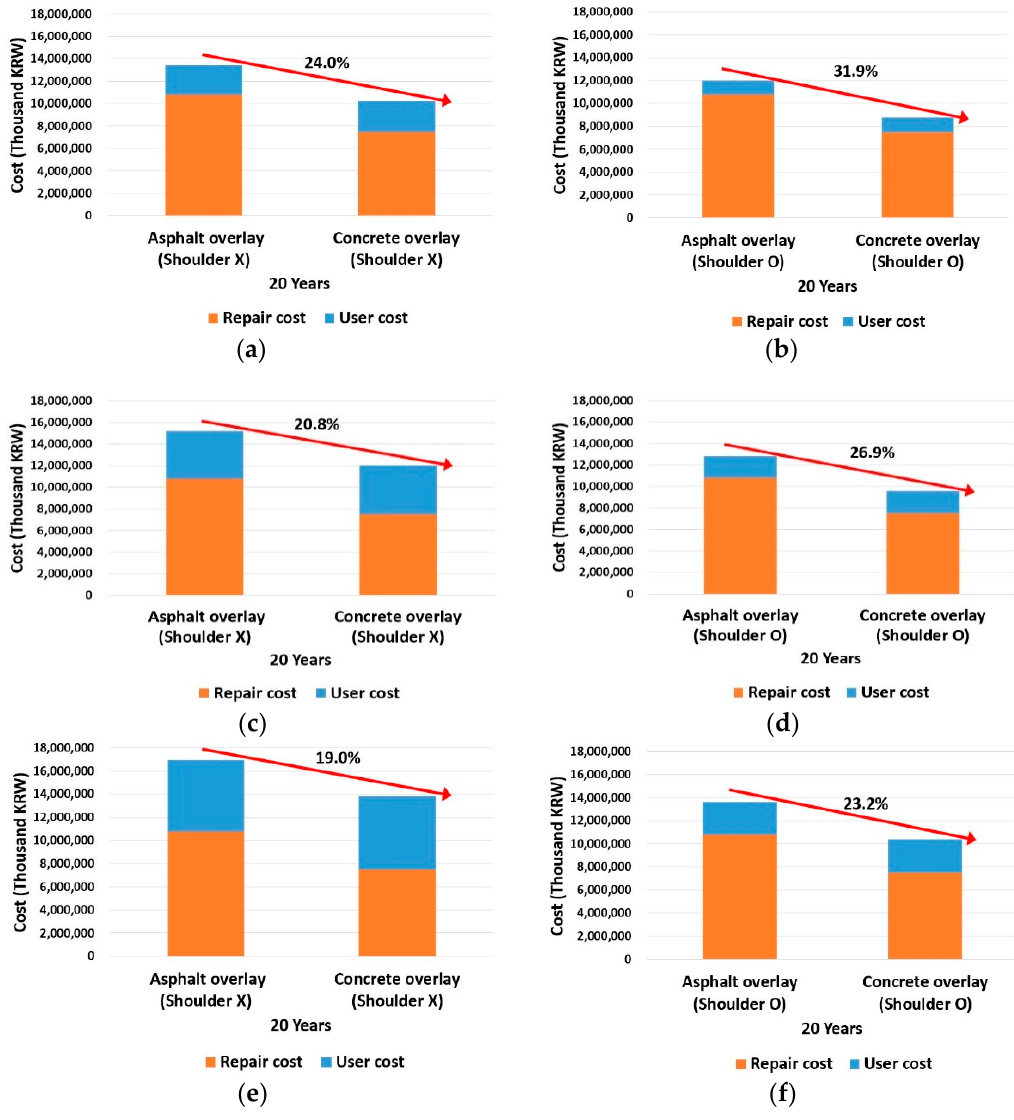
Figure 10. Economic analysis by 4-lane overlay method. ( a ) 4-lane 15,000 AADT Overlay Economical (Shoulder X). ( b ) 4-lane 15,000 AADT Overlay Economical (Shoulder O). ( c ) 4-lane 25,000 AADT Overlay Economical (Shoulder X). ( d ) 4-lane 25,000 AADT Overlay Economical (Shoulder O). ( e ) 4-lane 35,000 AADT Overlay Economical (Shoulder X). ( f ) 4-lane 35,000 AADT Overlay Economical (Shoulder O). Table 4. Concrete Overlay Economic